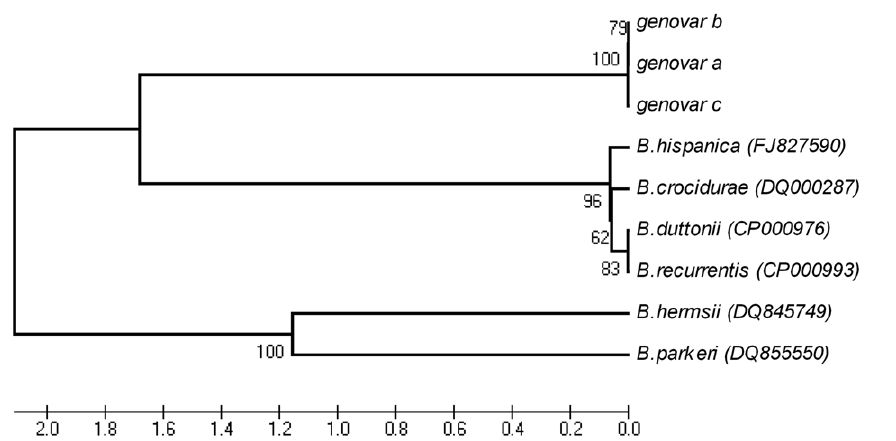
Figure 3. Phylogenic tree based on rrs-ile T spacer (IGS) sequences. The rrs-ile T spacer (IGS) sequences for 16 independent isolates from Israel and the West Bank belonging to genovars a to c were compared to IGS sequences from other Borrelia species (accession numbers are given in parentheses). The isolates in each genovar are listed in Table 1. The phylogenic tree was inferred using the UPGMA method as described in Figure 2. All positions containing gaps and missing data were eliminated from the dataset (Complete deletion option). There were a total of 349 positions in